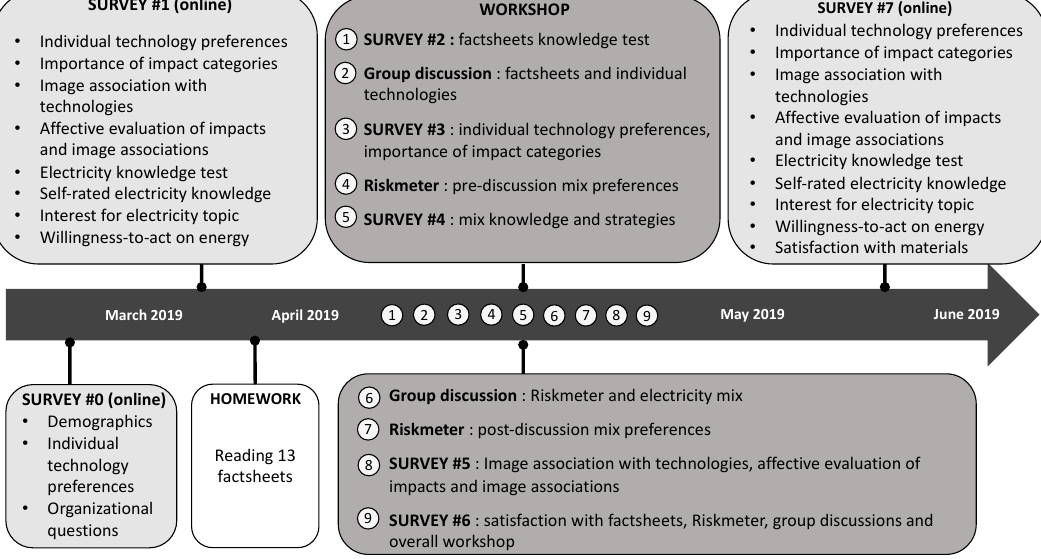
Figure1. Procedureused tocreate aninformedcitizenpanelin thecityofGenevawiththe measurements in all Figure 1. Procedure used to create an informed citizen panel in the city of Geneva with the measurements in all surveys.